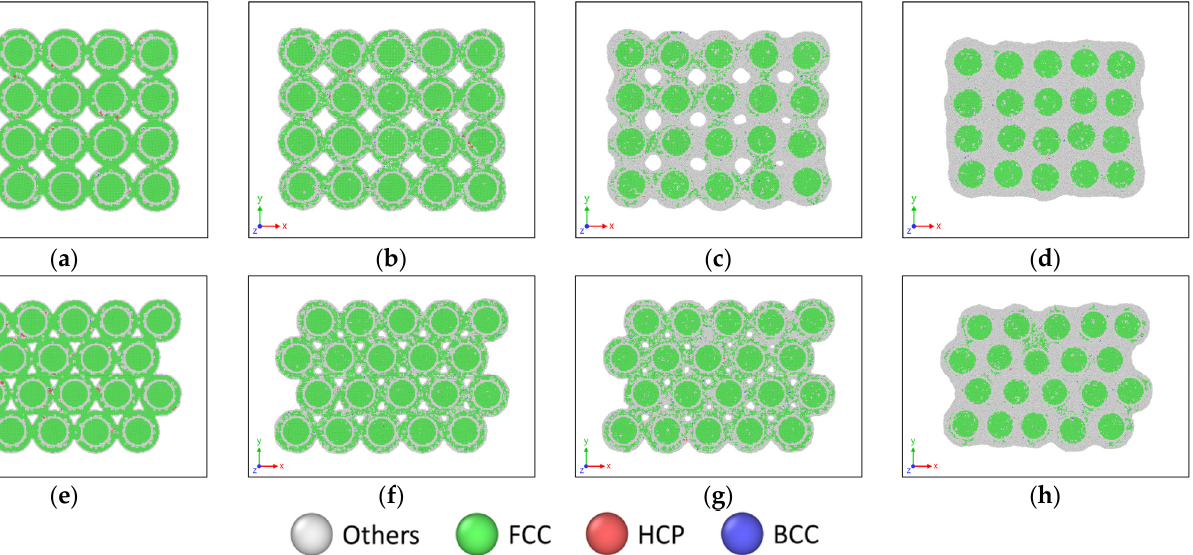
Figure 11. Example atomic configurations of stacked-NPs model with 30% core volume fraction in both types at different instants (temperatures): ( a , e ) at 298 K, ( b , f ) at 700 K, ( c , g ) at T a , and ( d , h ) at T nv .